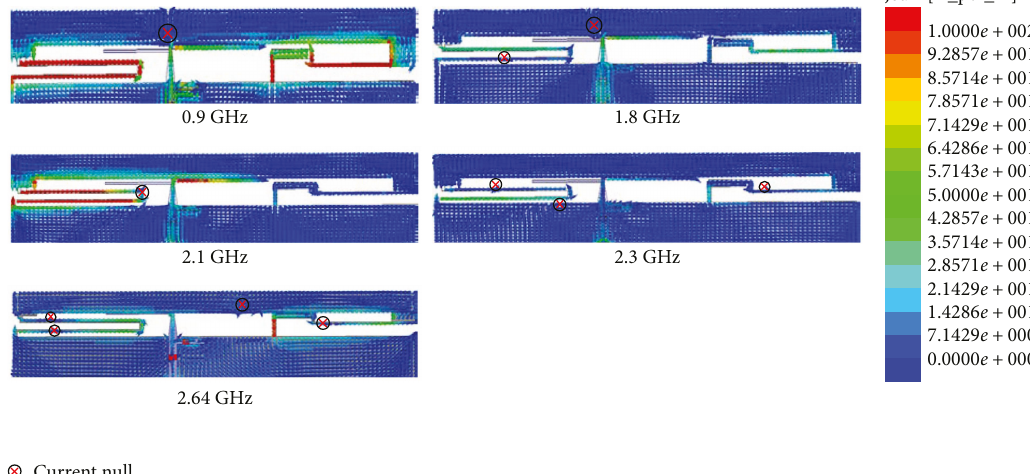
Figure 2: Vector current distribution of the proposed antenna at frequencies of 0.9GHz, 1.8GHz, 2.1GHz, 2.3GHz, and 2.64GHz.